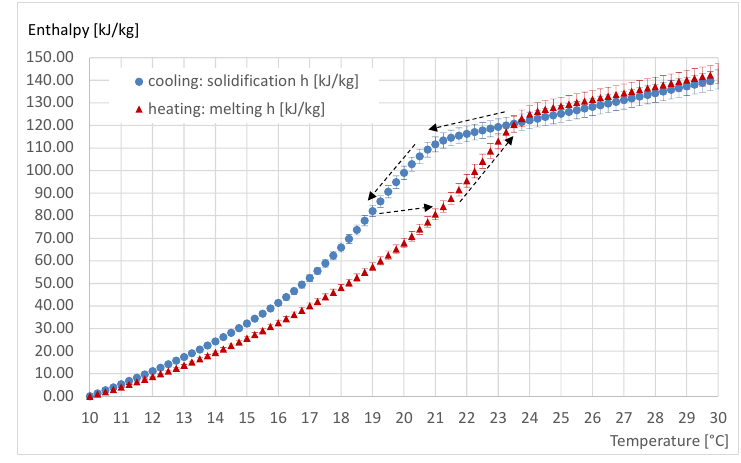
Figure 4. Partial enthalpy of PCM in modules [42].